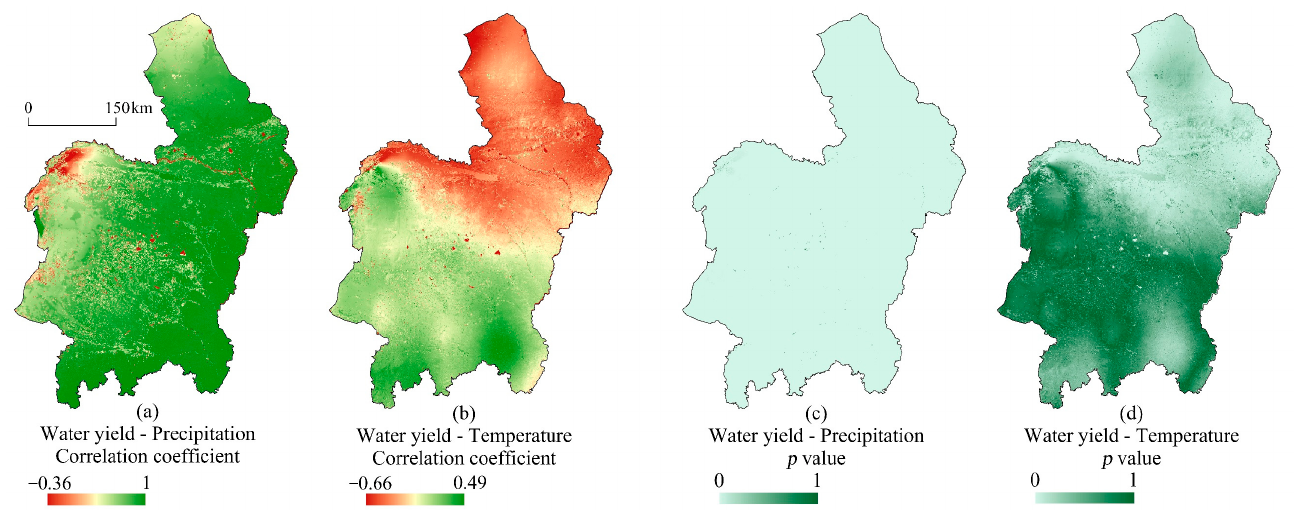
Figure 7. Correlation coefficient of precipitation and temperature with water yield ( a – b ) and the significance level ( c – d ) in the HBOY Region.